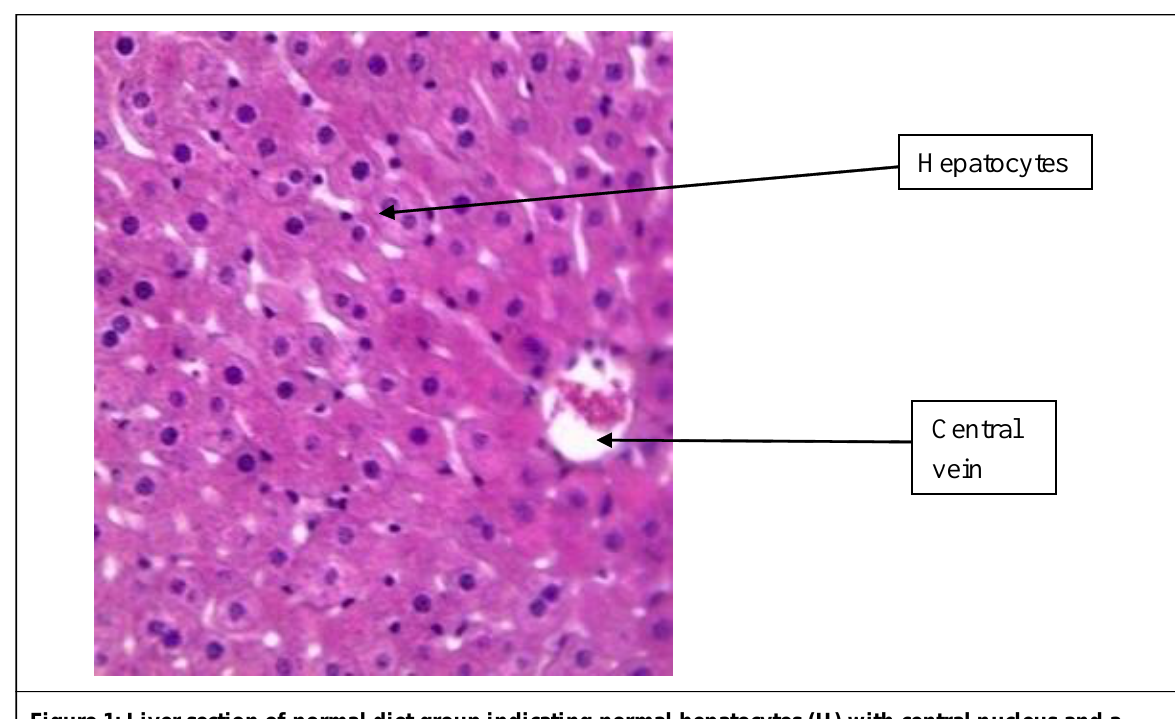
Figure 1: Liver section of normal diet group indicating normal hepatocytes (H) with central nucleus and a Central vein (V). X500  m